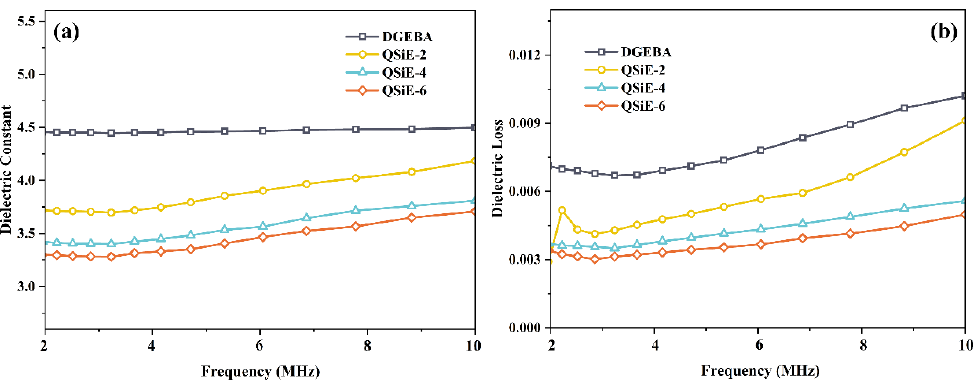
Figure 6. ( a ) Dielectric constant, ( b ) dielectric loss of cured thermosets.